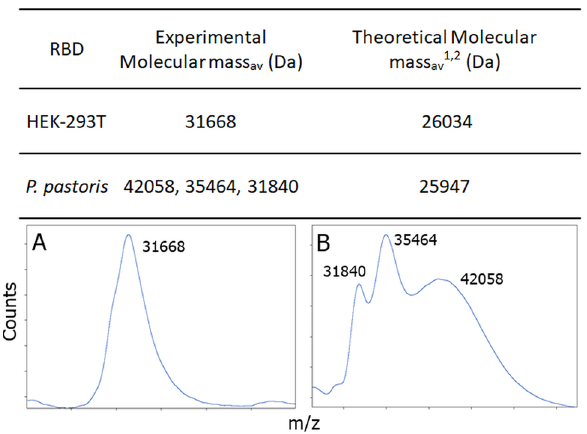
Figure 4. MALDI TOF Spectra for RBD Samples. ( A ) RBD prepared in HEK-293T and ( B ) RBD prepared in P. pastoris . As expected, the glycosylated species from P. pastor is have a broad mass. 1 Cys is oxidized, 2 Calculated without glycosylation.